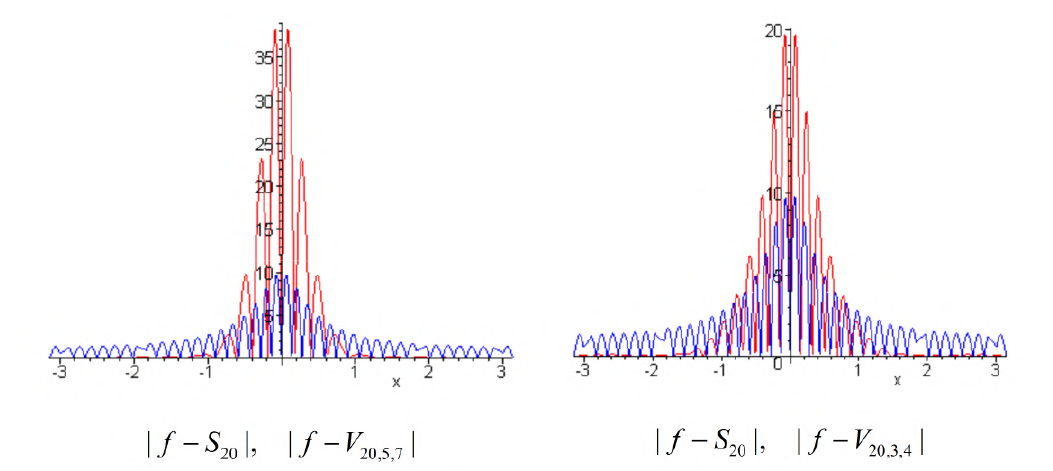
Figure 54: Presentation of paper